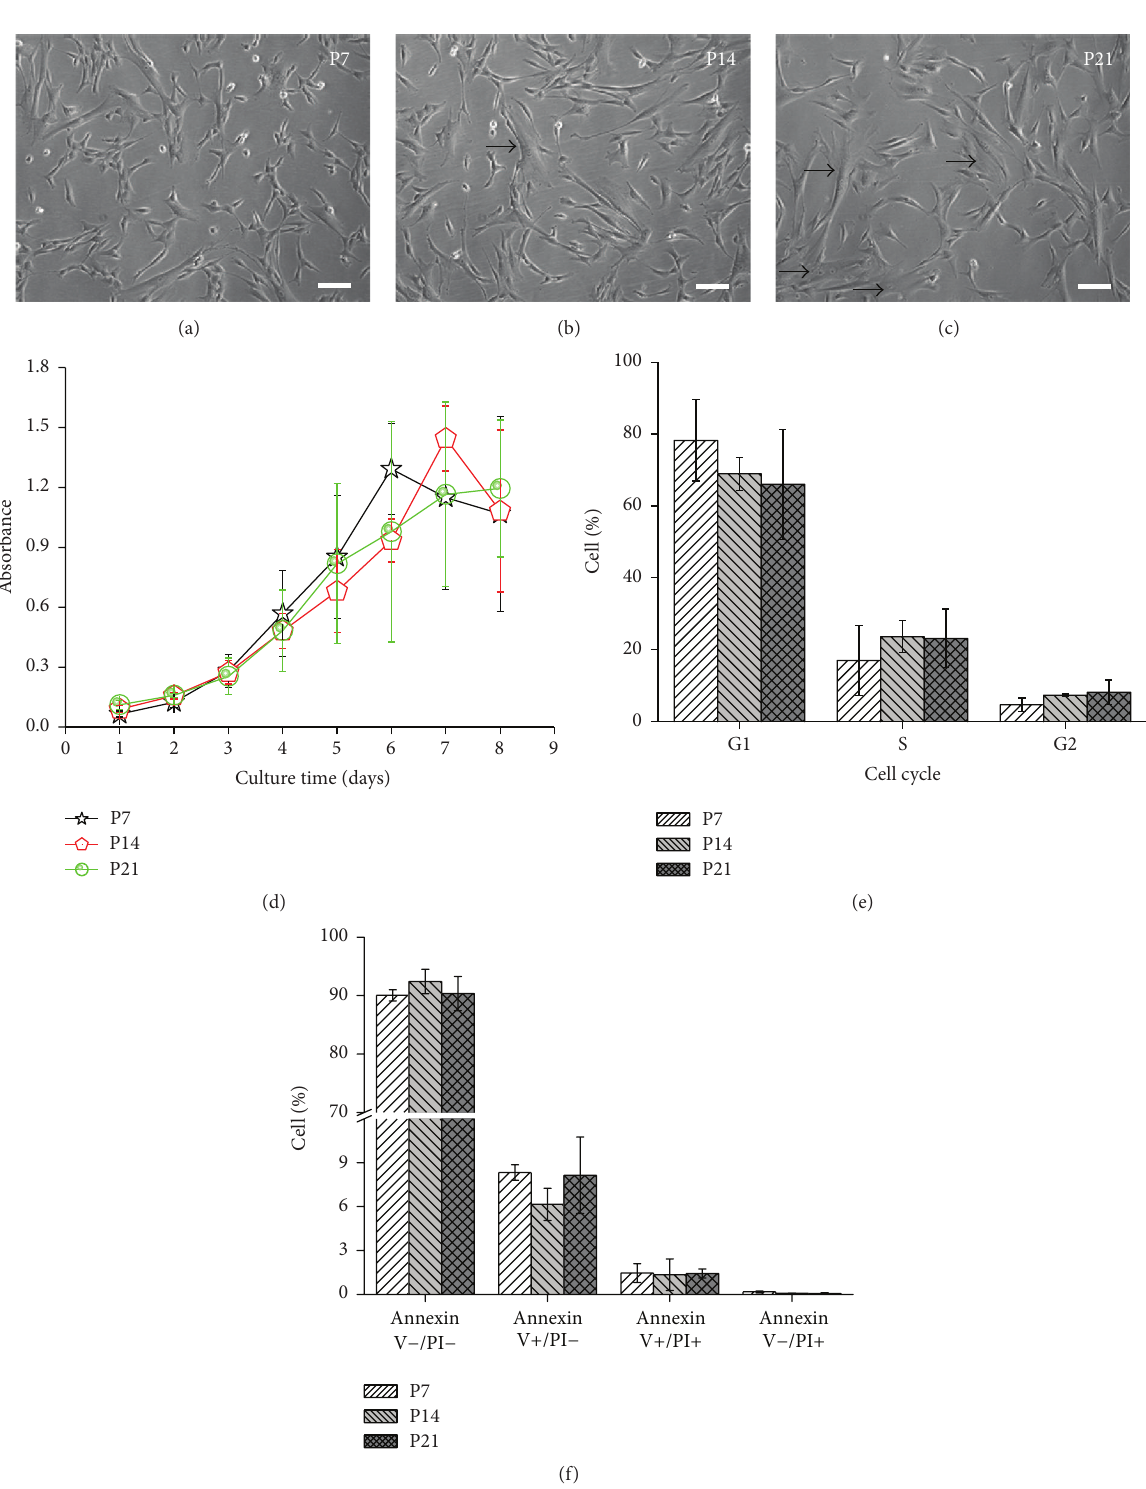
Figure 1: Morphology, proliferation, cell cycle, and apoptosis of WJ MSCs (Wharton’s jelly-derived mesenchymal stem cells) in the early, middle, and late phases. (a) Representative phase-contrast micrographs showed that there were many small raised cells with a fibroblast-like appearance in the early phase, (b) then some cells gained an irregular and flat morphology in the middle phase, and (c) more cells appeared to be irregular and flat in the late phase. Arrows indicated the irregular and flat cells. Bar: 100 𝜇 m. (d) CCK8 (cell counting kit-8) assay showed that the proliferation rate of WJ MSCs decreased gradually in long-term culture in vitro. (e) S and G2 phase block phenomenon might exist at higher passages (P14 and P21) compared to P7. (f) There were no significant differences in apoptosis among three